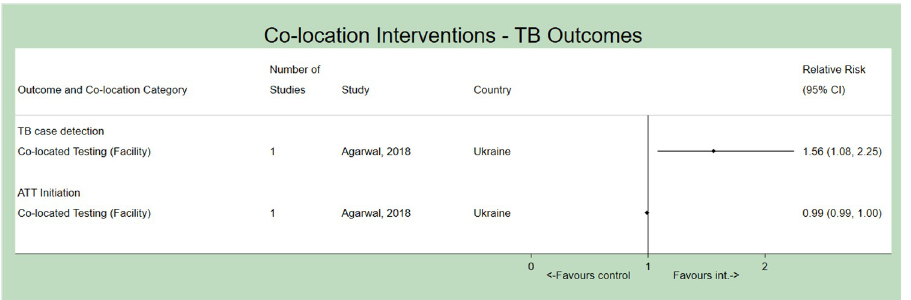
tuberculosis Treatment.